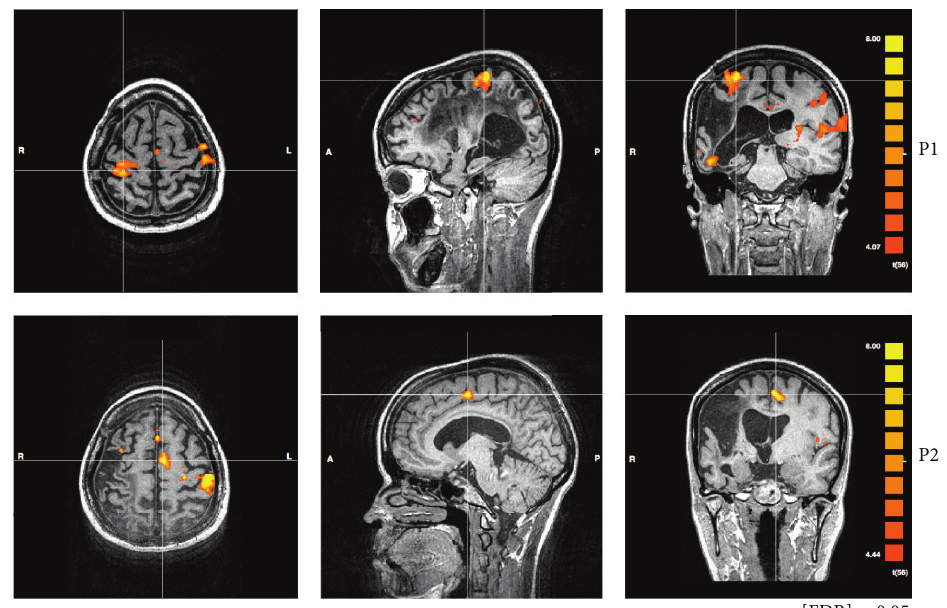
Figure 5: fMRI of patient #5 showing reduced perilesional activity at P2 with respect to P1. fMRI maps were obtained for the hand movements of the paretic hand. Images show decreased perilesional activity after